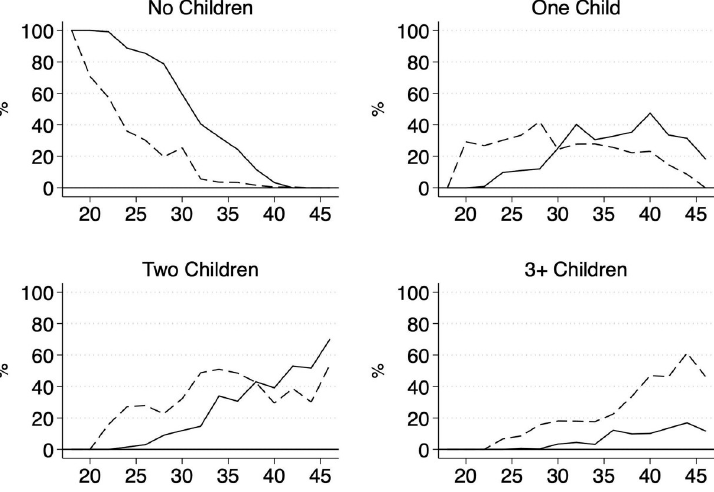
Fig 2. Distribution of the number of children categories by education and age. Data are from SOEP, v.34; own calculations; Lower education = dashed lines; Higher education = solid lines.